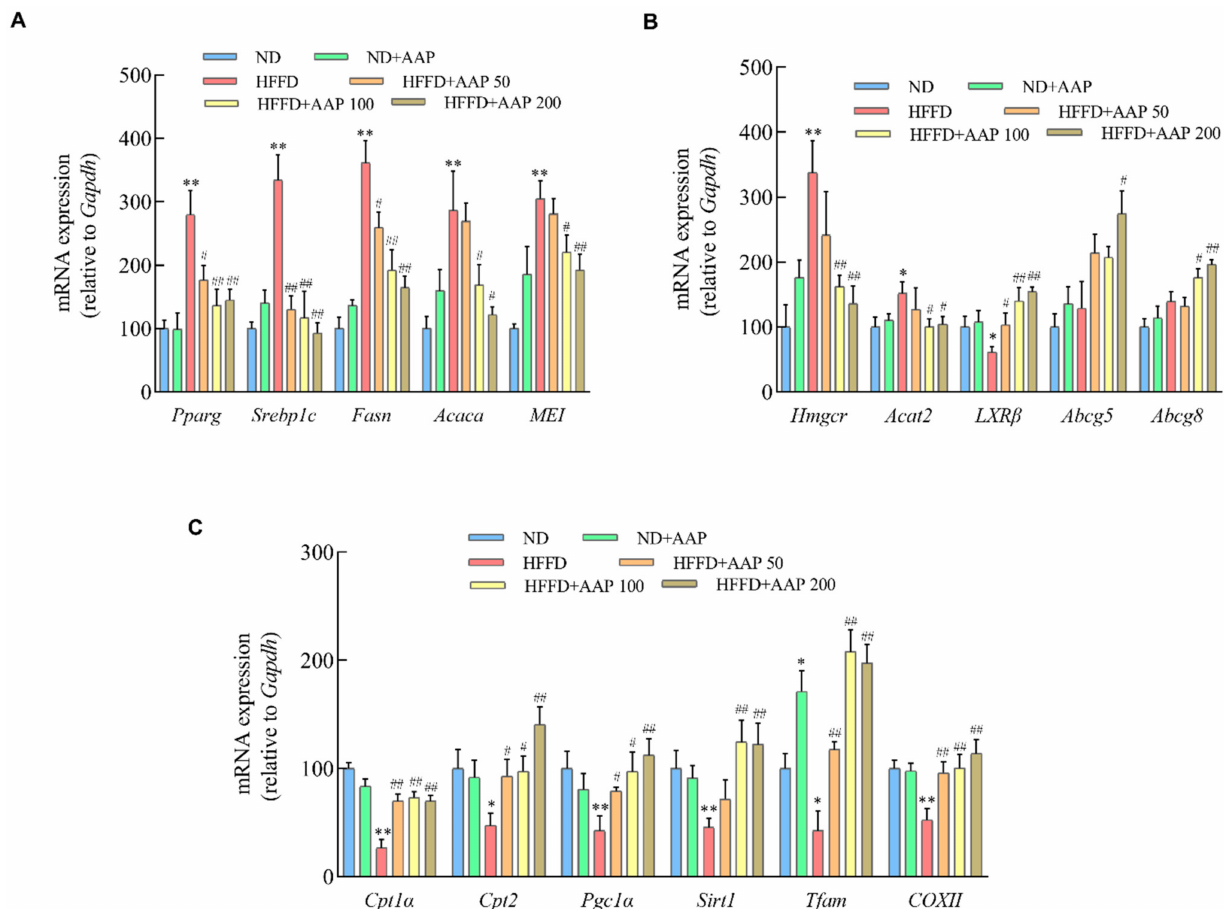
Figure 8. The effects of Auricularia auricula-judae polysaccharides on liver lipid metabolism-related gene expressions in obese mice that were induced by HFFD. ( A ) mRNA levels of lipogenic genes including Pparg , Srebp1c , Fasn , Acaca , and ME1 ; ( B ) The mRNA levels of cholesterol synthesis genes including Hmgcr , Acat2 , LXR β , Abcg5 , and Abcg8 ; ( C ) mRNA levels of lipolytic genes and mitochondrial-related genes including Cpt1a , Cpt2 , Pgc1 α , Sirt1 , Tfam , and COXII . The data are presented as the mean ± SEM, n ≥ 6, * p < 0.05, ** p < 0.01, vs. ND group, # p < 0.05, ## p < 0.01 vs. HFFD